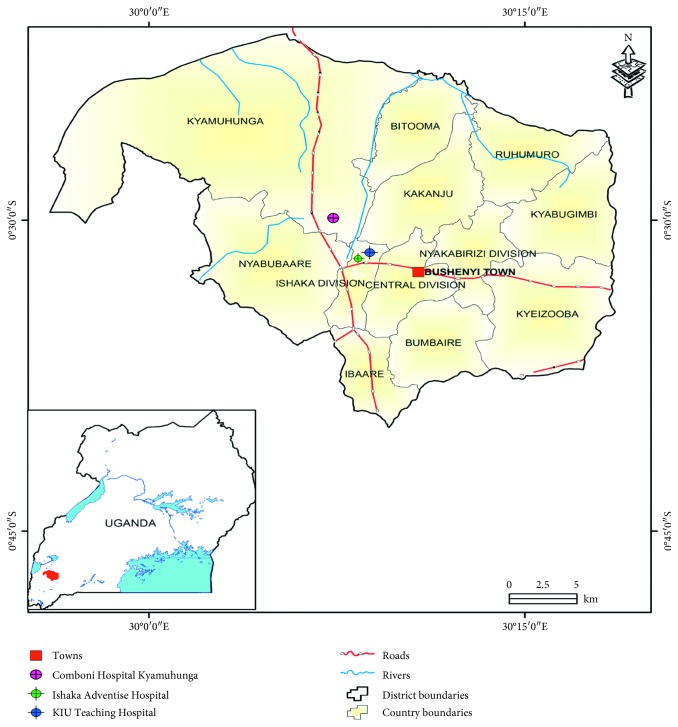
Map of Bushenyi District showing the study area (Uganda Bureau of Statistics, UBOS, 2015). Copyright © 1998–2018: Copyrights reserved to United Nations Office for the Coordination of Humanitarian Affairs, based on the OCHA/relief web.